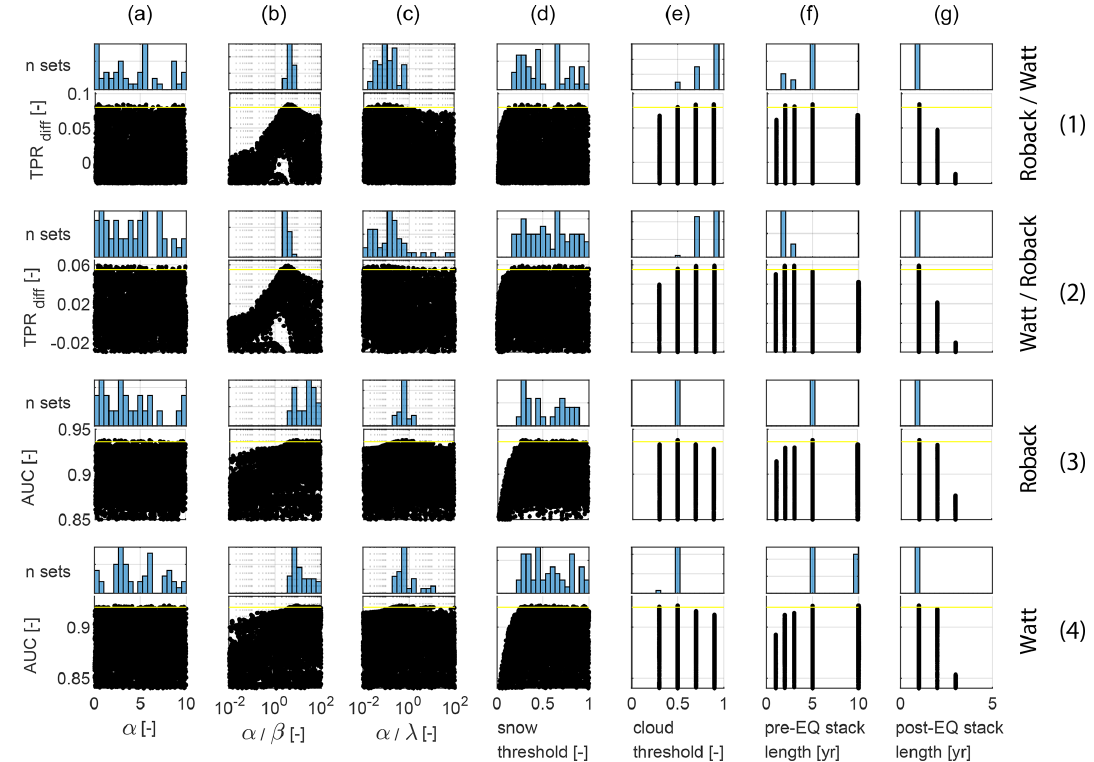
Figure 3. Dotty plots and posterior parameter distributions for the Gorkha case study for the seven tuneable parameters associated with ALDI (columns) evaluated using two of the test datasets (Watt and Roback) and two performance metrics (rows): (1) TPR diff , the difference in TPR between ALDI and the competitor inventory at the FPR defined by the competitor inventory, and (2) AUC, the area under the ROC curve, a more general indicator of classifier performance over the full range of FPRs. “Roback/Watt” refers to using Roback as the check dataset and Watt as the competitor in row 1; “Watt/Roback” refers to the converse in row 2. Roback is used as the check dataset in row 3, and Watt is the check dataset in row 4. Points plotting above the yellow line are results for the best 100 parameter values. In each case the parameter distributions are for the best 100 parameter sets evaluated using the same metric and datasets as the dotty plot below it. Dotty plots for the other Gorkha inventories and for all other sites are given in the Supplement. EQ: